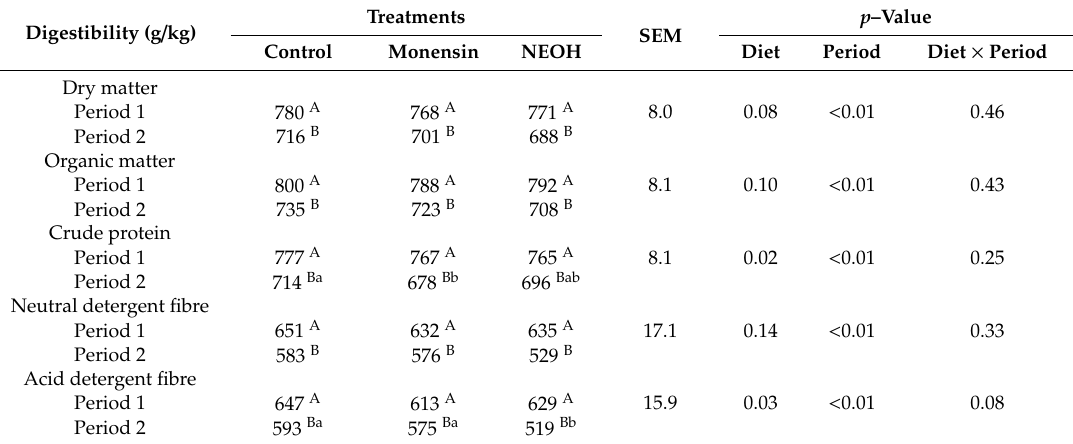
Table 2. Supplementation e ff ects of monensin and nitroethanol (NEOH) to lamb diet in